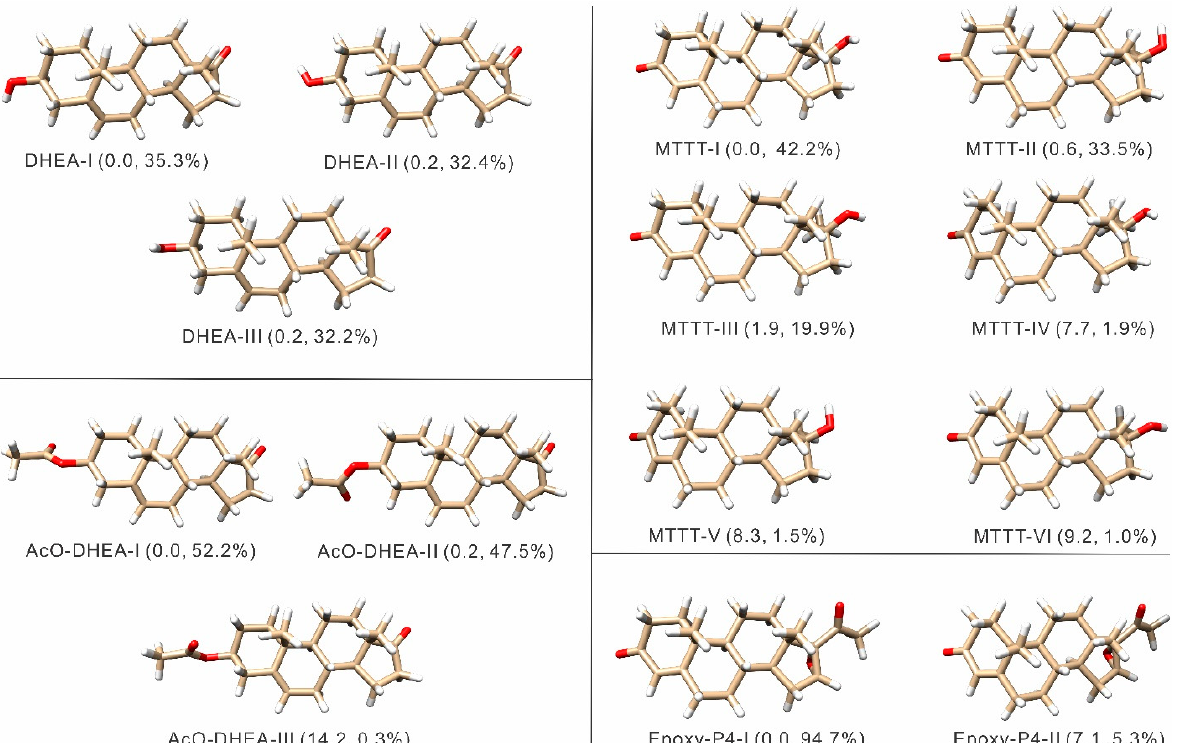
Figure 2. Optimized geometries of the conformers of the four steroids at the B3LYP − D3BJ/def2 − TZVPD level of theory with the PCM of DMSO. The relative free energies in kJ mol − 1 and the Boltzmann percentage abundances at 298 K are provided in brackets.